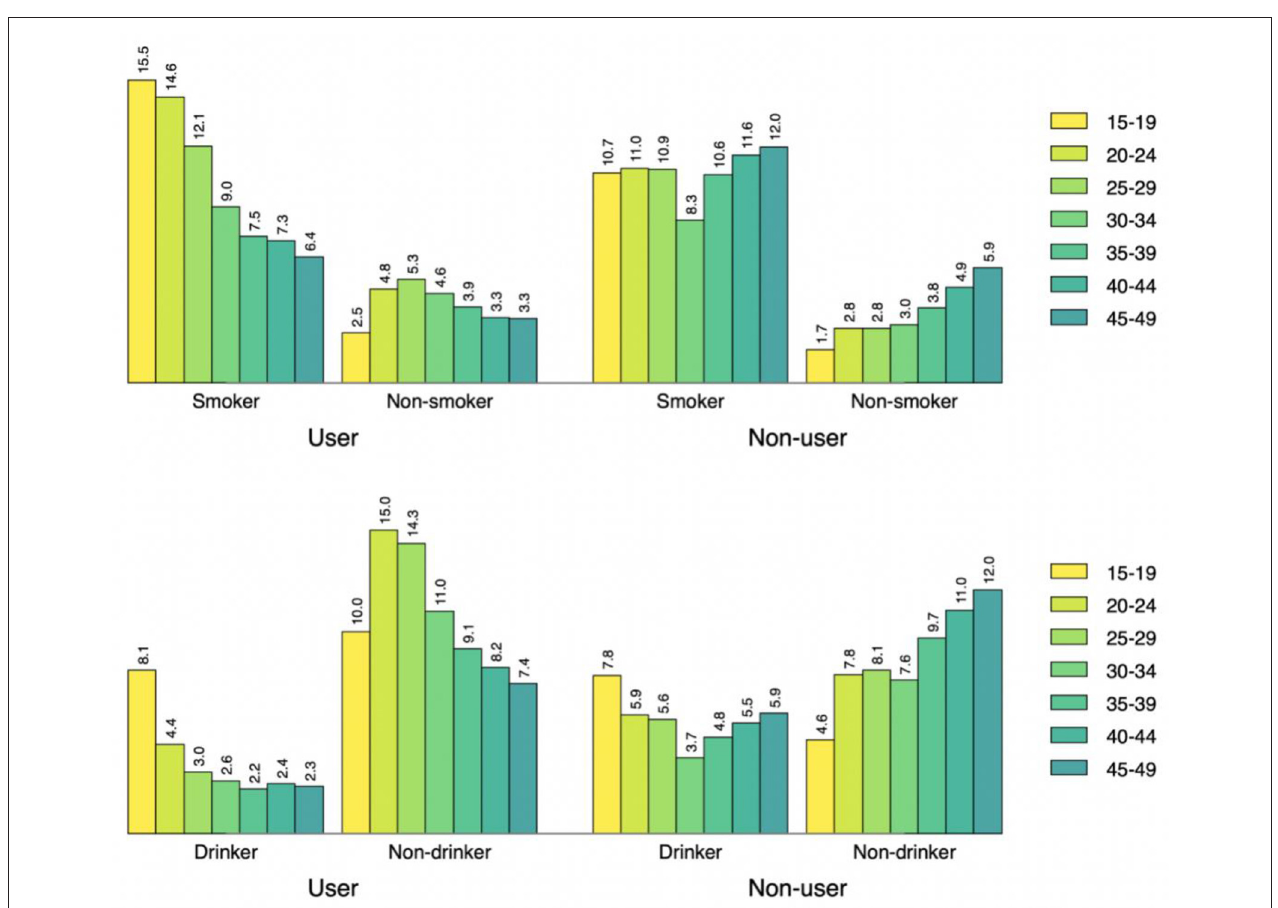
FIGURE 1 | Smoking status across the age groups by internet use status.